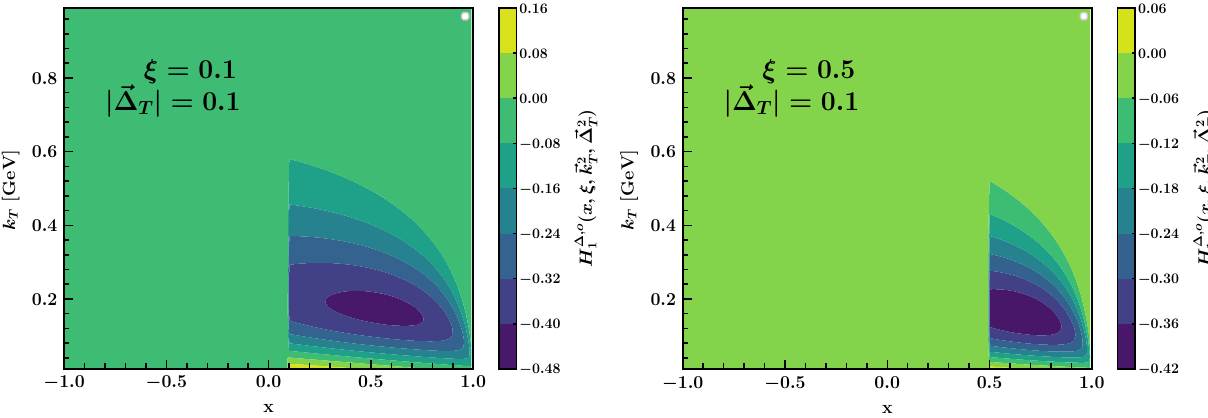
| for different ξ values. The left and right panels H (cid:3), o T